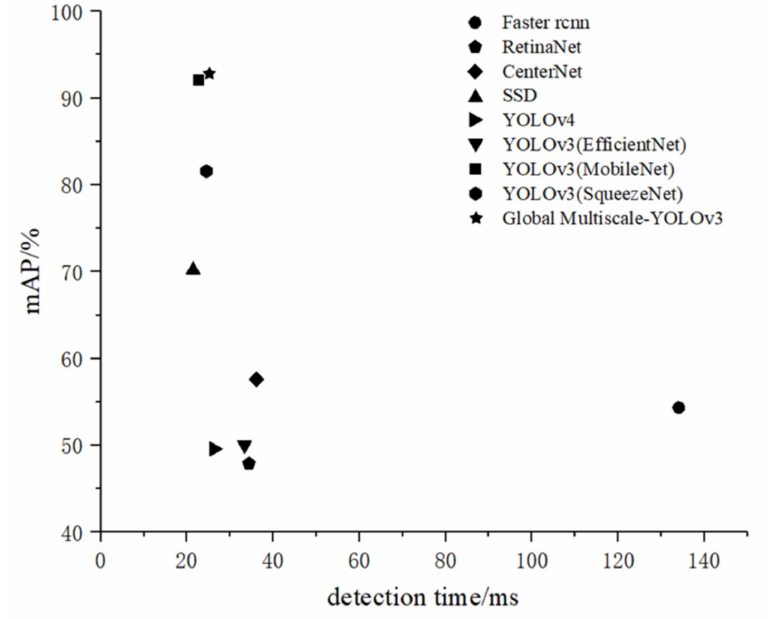
Figure 11. The relationship between mAP and detection